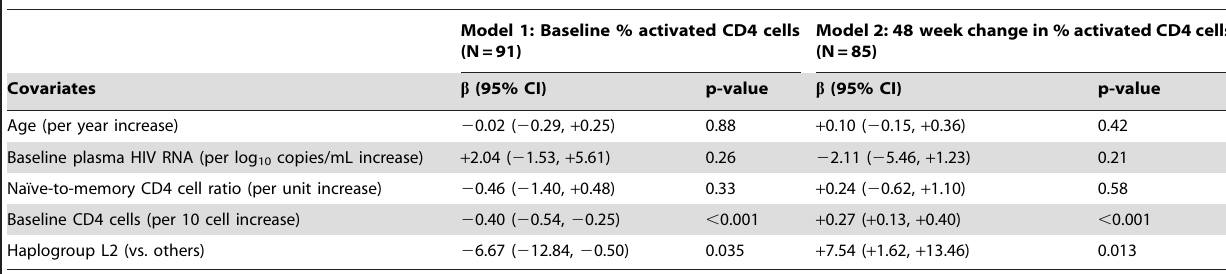
Table 4. Multivariate models of associations between baseline covariates, haplogroup L2, and percentage CD4 cell